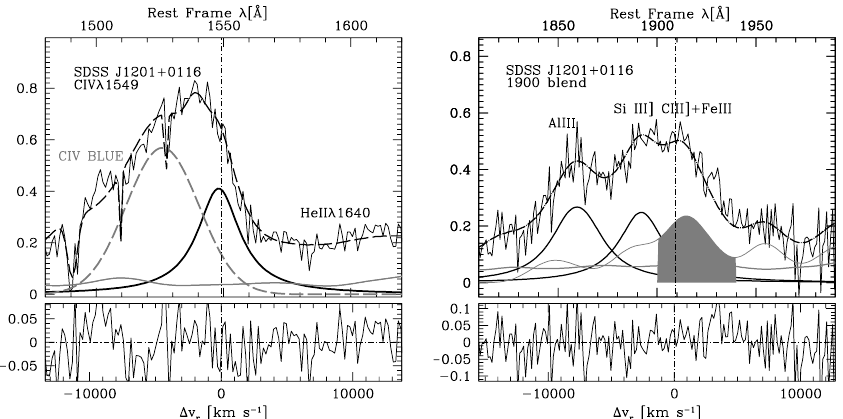
Fig. 1. The C IV (cid:21) 1549 (left) and (cid:21) 1900 (right) spectral regions of the NLSy1-like object SDSS J120144.36+011611.6. The major constituents of the blend are identi(cid:12)ed. The thick grey line shows the scaled template Fe II emission; the thin grey line is for Fe III. The shaded area corresponds to the C III] (cid:21) 1909 and Fe III (cid:21) 1914 lines whose intensity is